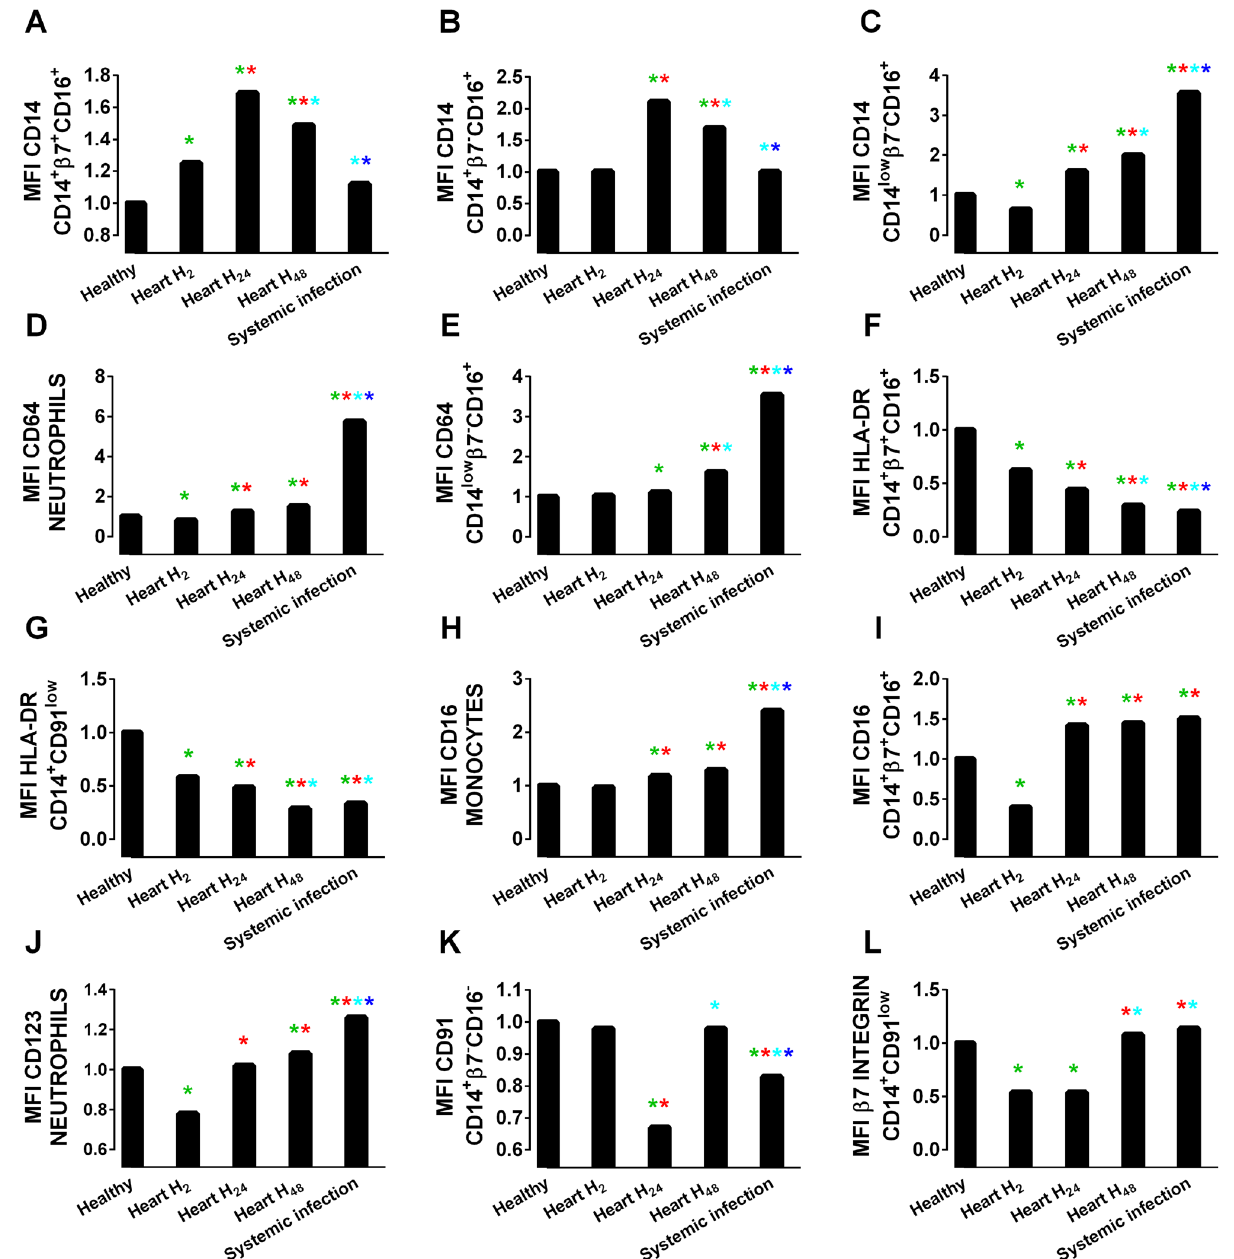
Figure 4. The 12 most relevant MFIs of selected markers for iDAR score construction. ( A ), CD14 expression on CD14 + β7 + CD16 + monocytes ( B ), CD14 expression on CD14 + β7 - CD16 + monocytes ( C ), CD14 expression on CD14 low β7 - CD16 + monocytes ( D ), CD64 expression on neutrophils ( E ), CD64 expression on CD14 low β7 - CD16 + monocytes ( F ), HLA-DR expression on CD14 + β7 + CD16 + monocytes ( G ), HLA-DR expression on CD14 + CD91 low monocytes ( H ), CD16 expression on monocytes ( I ), CD16 expression on CD14 + β7 + CD16 + monocytes ( J ), CD123 expression on neutrophils ( K ), CD91 expression on CD14 + β7 - CD16 - monocytes ( L ), and integrin β7 expression on CD14 + CD91 low monocytes in the indicated patient groups versus healthy donors. The data are presented as the mean ± standard error of the mean (SEM) in healthy, cardiac surgery patients at 2 (H 2 ), 24 (H 24 ), 48 (H 48 ) hours and BSI patients. The data scale was normalized to reflect the relative increase or decrease compared to healthy persons. P < 0.05 Healthy “green asterisk”; Heart H 2 “red asterisk”; Heart H 24 “light blue asterisk”; Heart H 48 “dark blue